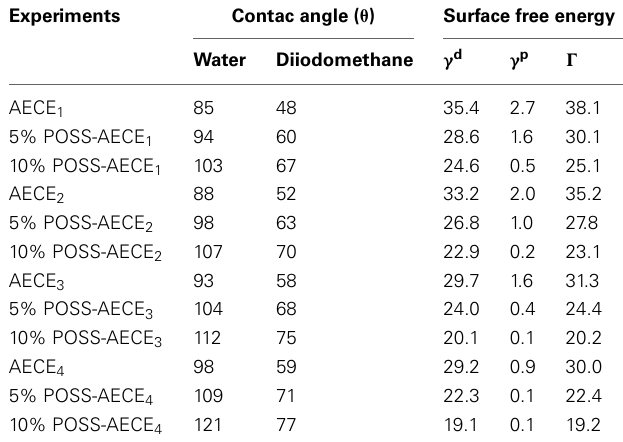
Table 3 | Contact angle and surface free energy of neat AECE and POSS-AECE